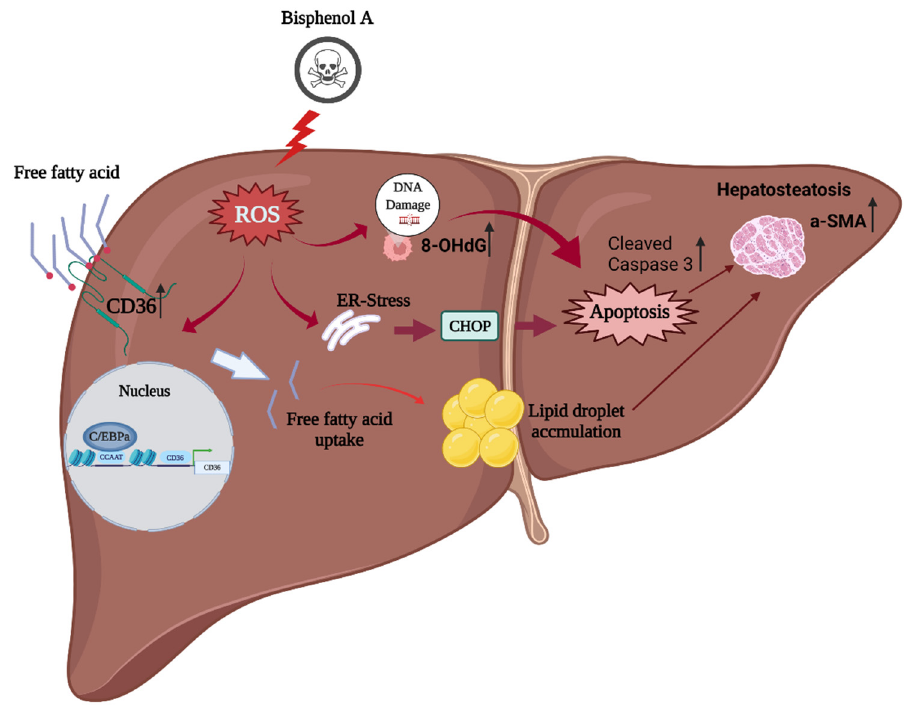
Figure 6. The proposed mechanism of BPA coupled with a high-fat diet in enhancing ROS-induced hepatic lipid accumulation and liver fibrosis: BPA + HFCCD increases intracellular ROS production, which induces the expression of CCAAT-enhancer-binding protein α (C/EBP α ) and CD36, and promotes free fatty acid uptake. BPA exposure aggravates HFCCD-induced liver damage, leading to cleaved caspase-3 activation for apoptosis, steatohepatitis, and acceleration of the fibrotic process (due to α -SMA overexpression). The figure was created using Biorender.